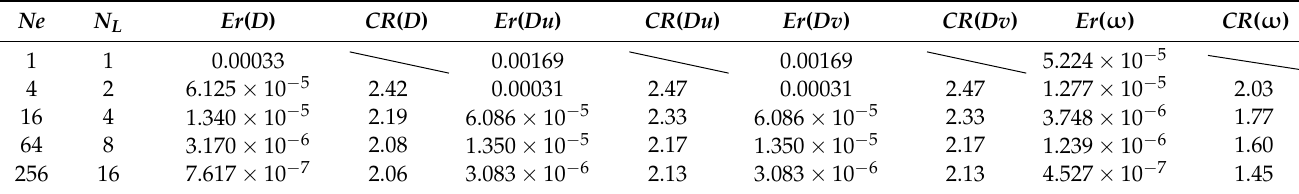
Table 3. N h = N v = 1, the L 2 error for each variable, and the corresponding CR.